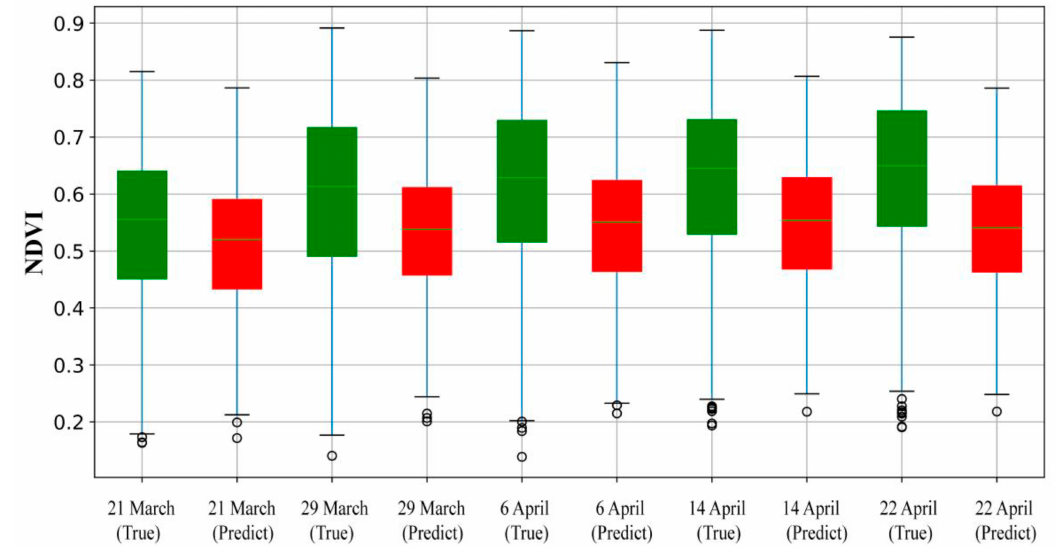
Figure 8. Comparison of predicted NDVI values (red) and observed NDVI values (green).